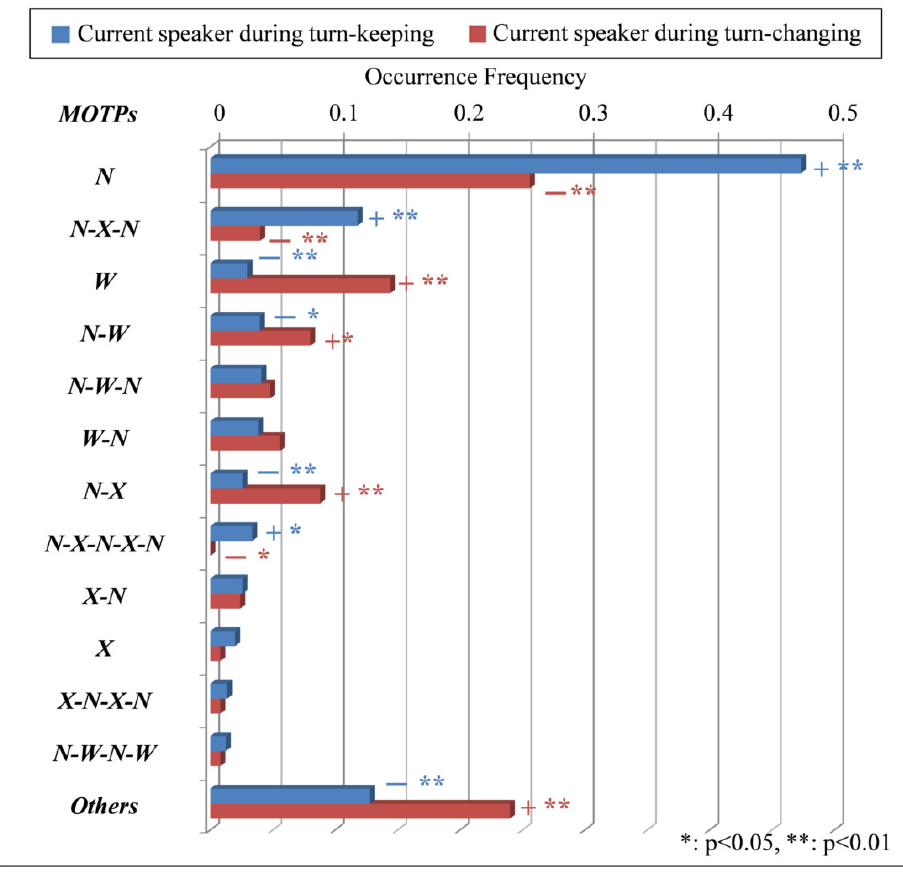
Figure 4. Occurrence frequency of current speaker’s mouth opening transition patterns (MOTPs) during turn-keeping and turn-changing. Vertical axis indicates the type of MOTP. Numerical value on the horizontal axis indicates the occurrence frequency of each